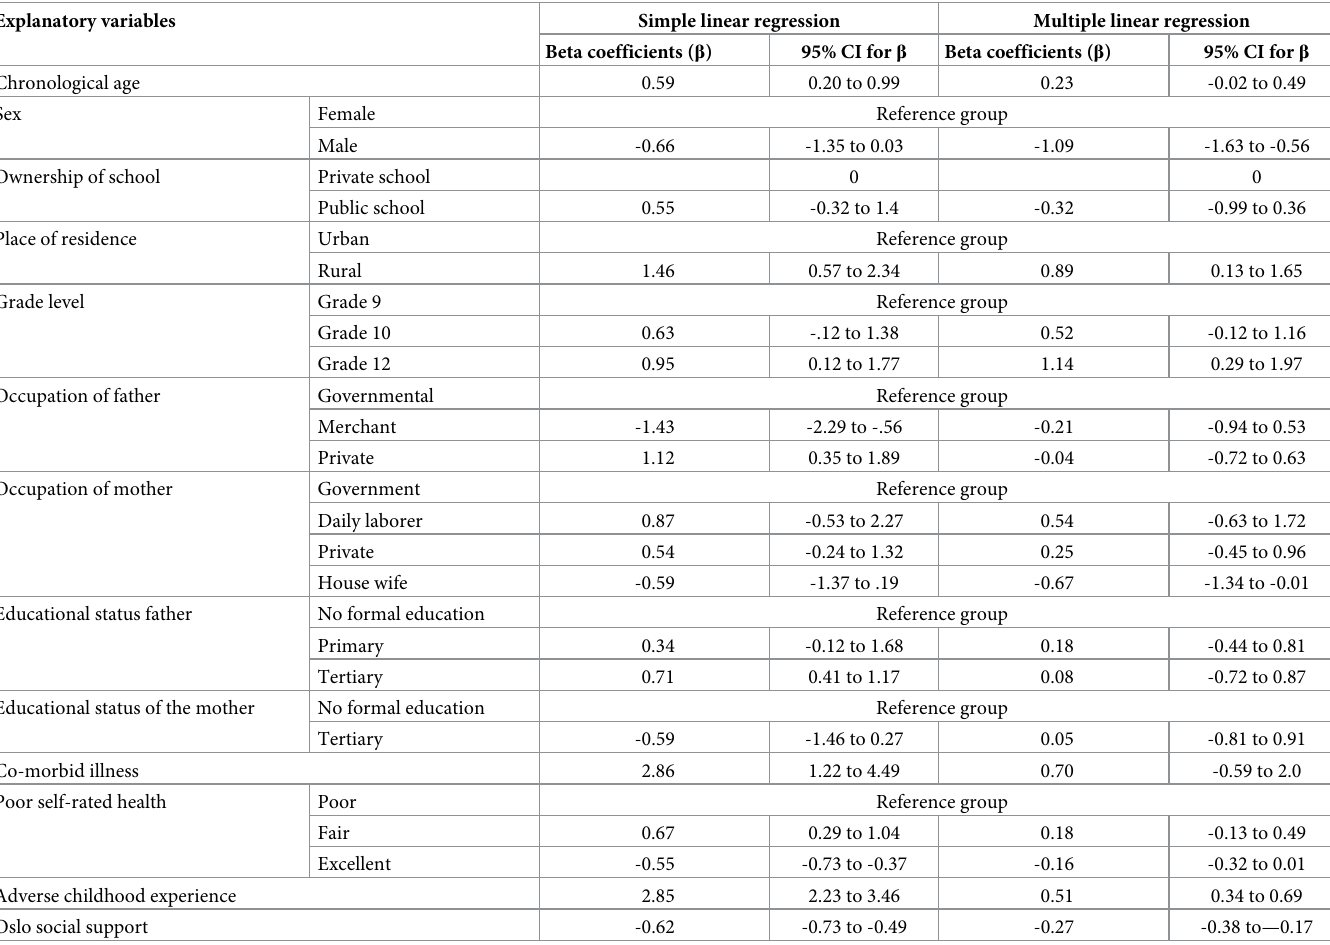
Table 2. Adjusted multiple linear regression model showing factors independently associated with depression among school-going adolescent in Jimma town, Southwest Ethiopia (n =